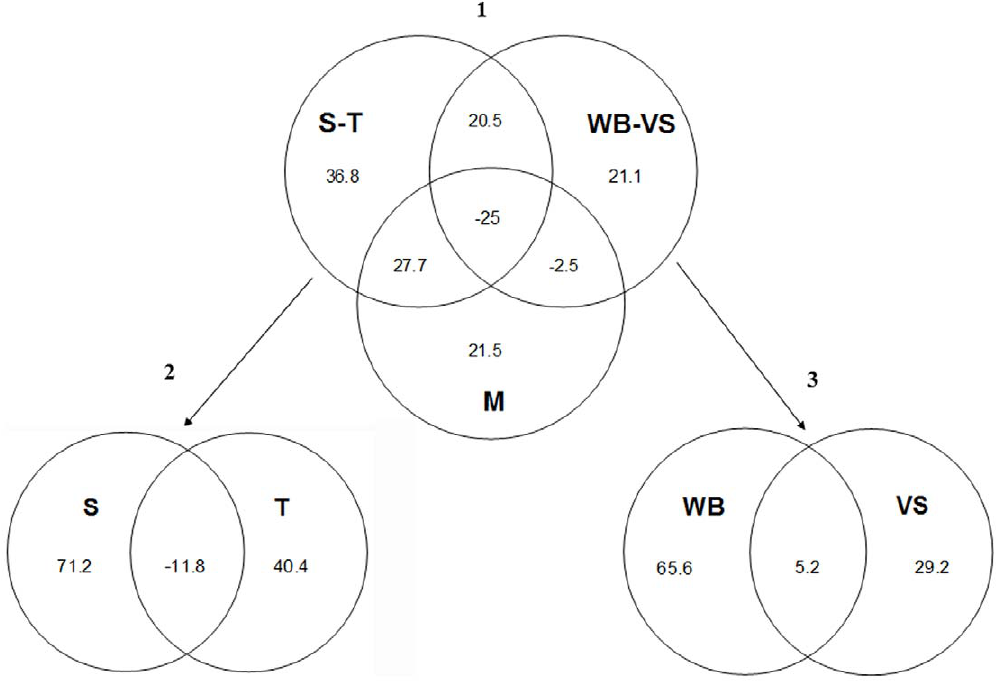
Figure 3. Factors implicated in AIV ecology in Spanish wetlands: results of variation partitioning of the final model in space-time (S- T), wild bird community-vegetation structure (WB-VS) and meteorological (M) factors (1), and of the partial models obtained for the space (S) – time (T) factor (2), and for the wild bird community (WB) – vegetation structure (VS) factor (3). Values shown in diagrams are the percentages of explained variation.